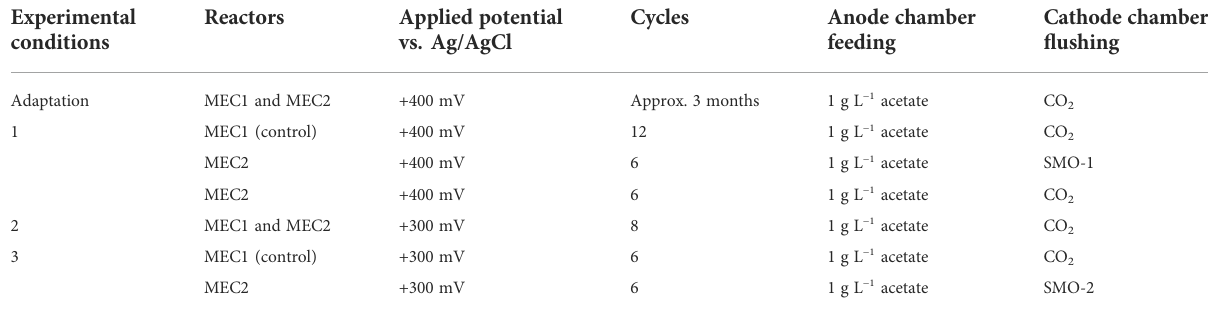
TABLE 1 Overview of the experimental conditions of MEC1 and